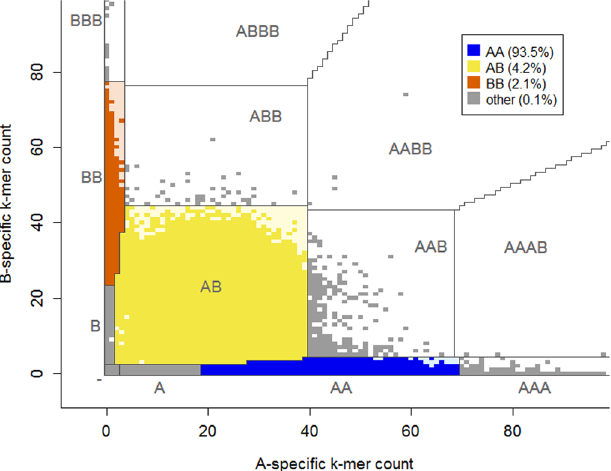
Figure 2. Illustration of genotype calling based on the frequencies of two k -mers. The parameters that define boundaries between genotypes are estimated from the k -mer frequency data of each individual. By default, only conventional genotypes are reported in the output. “A” denotes the reference allele, and “B” denotes an alternative allele. The estimated depth of coverage ( λ ) of the individual used in this example was